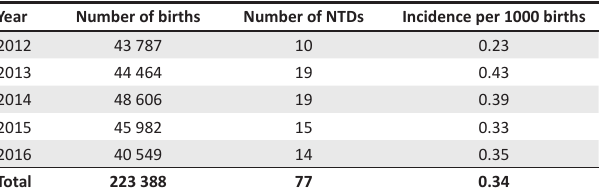
TABLE 1: Birth statistics and incidence of neural tube defects in the Free State province from 2012 to